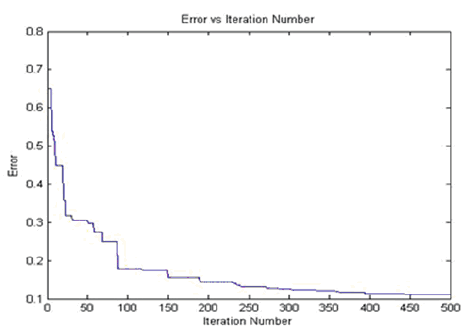
Figure 6: PIMA-Iteration vs. Error